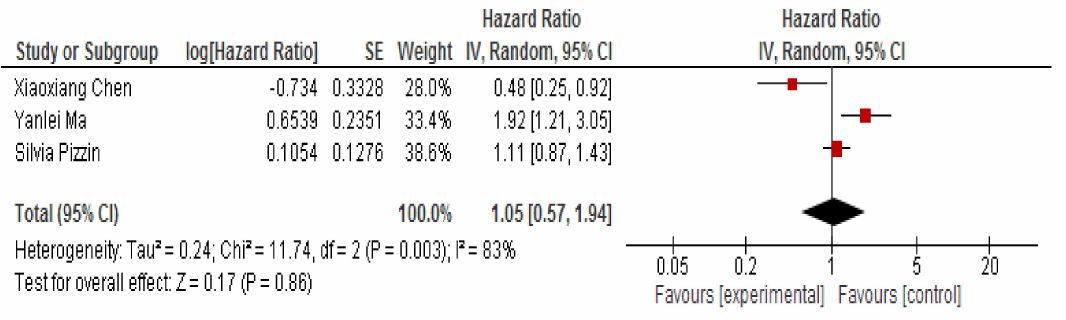
Figure 4. Forest plot for meta-analysis of HR using a random-e ff ects model.